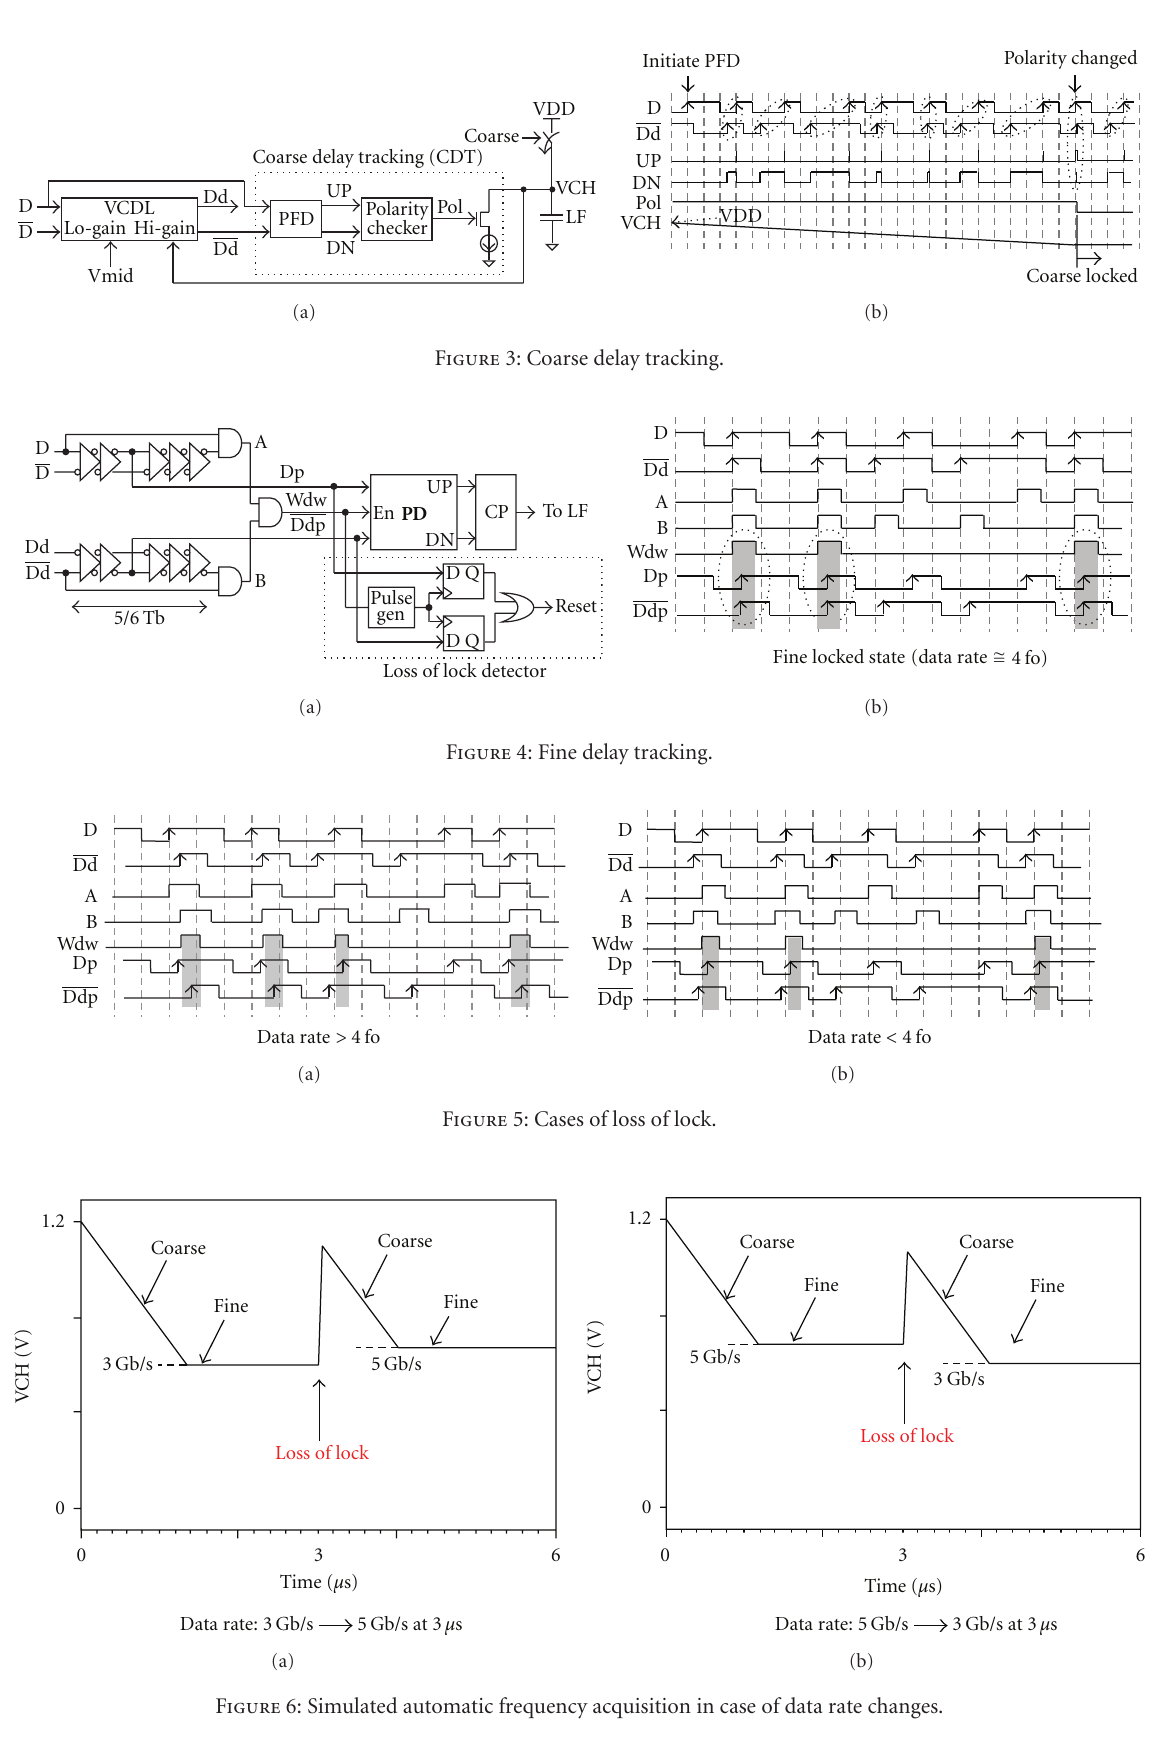
Figure 6: Simulated automatic frequency acquisition in case of data rate